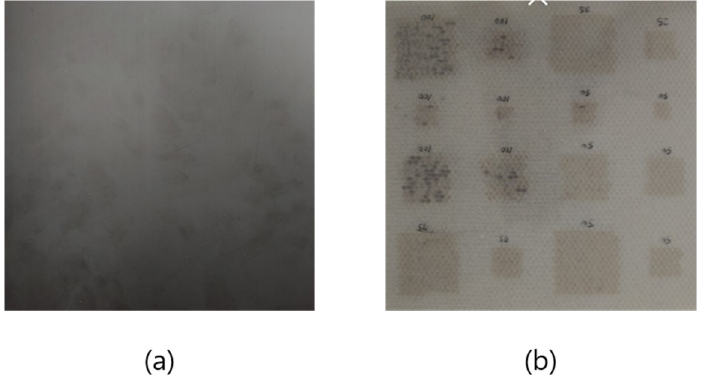
Figure 3. Aramid honeycomb-cored sandwich panel as a test sample. ( a ) The front face skin with CFRP and ( b ) the rear face skin with GFRP.